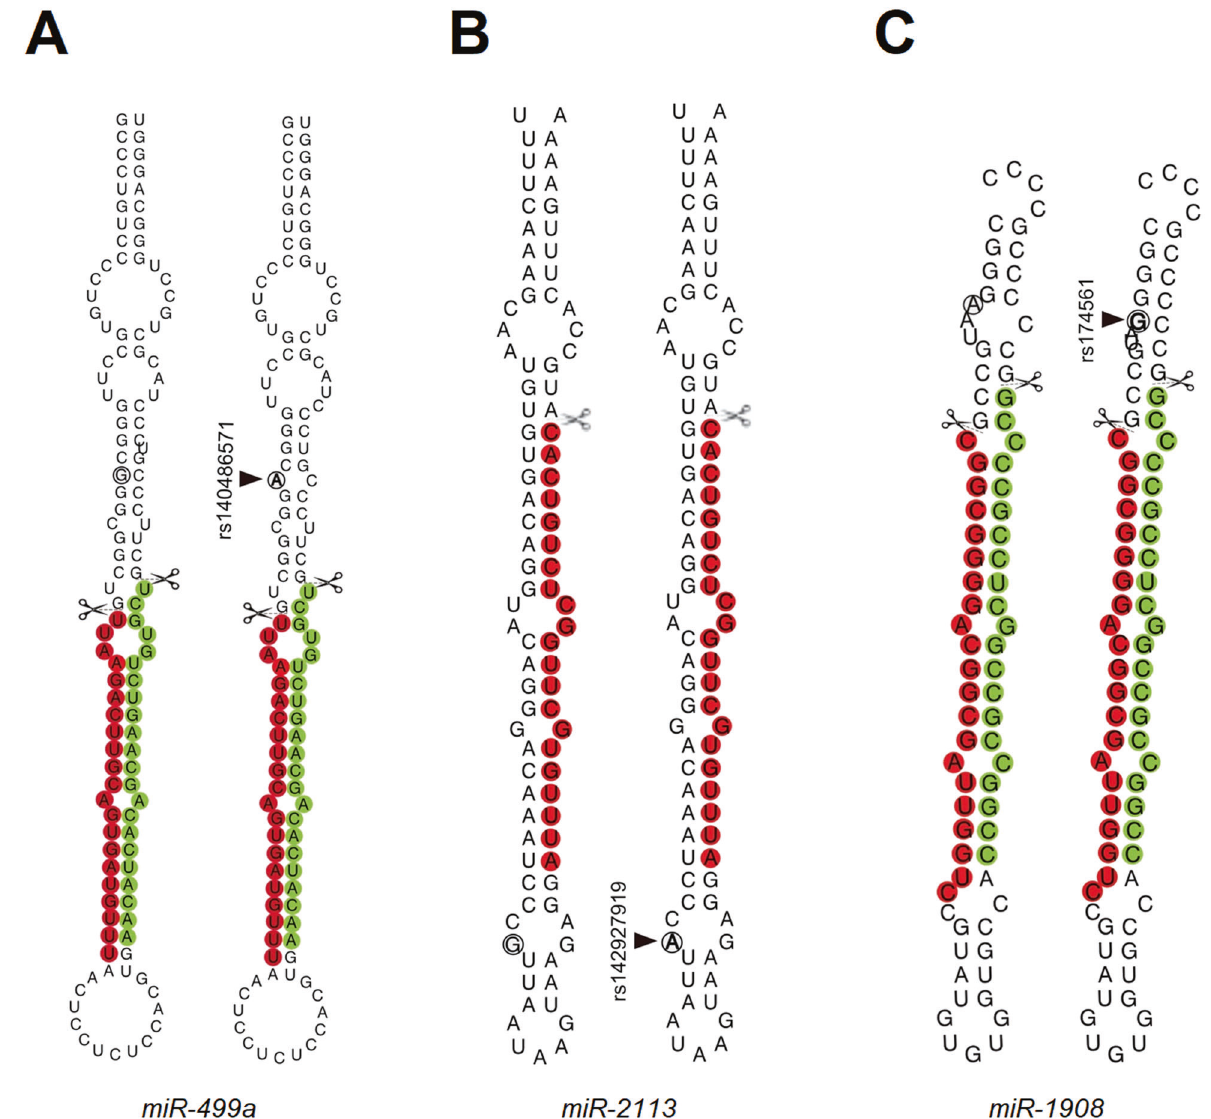
Fig. 1 Secondary structure prediction. Minimum free energy (MFE) secondary structure prediction of A miR-499a wild-type and rs140486571 (G/A); B miR-2113 wild-type and rs142927919 (G/A) and C miR-1908 wild-type and rs174561 (A/G) sequences. The positions of the variant nucleotides are indicated by black circles. Regions of the mature miRNAs are highlighted in colour (green for 3p, red for 5p). Drosha cleavage sites on both strands are indicated by